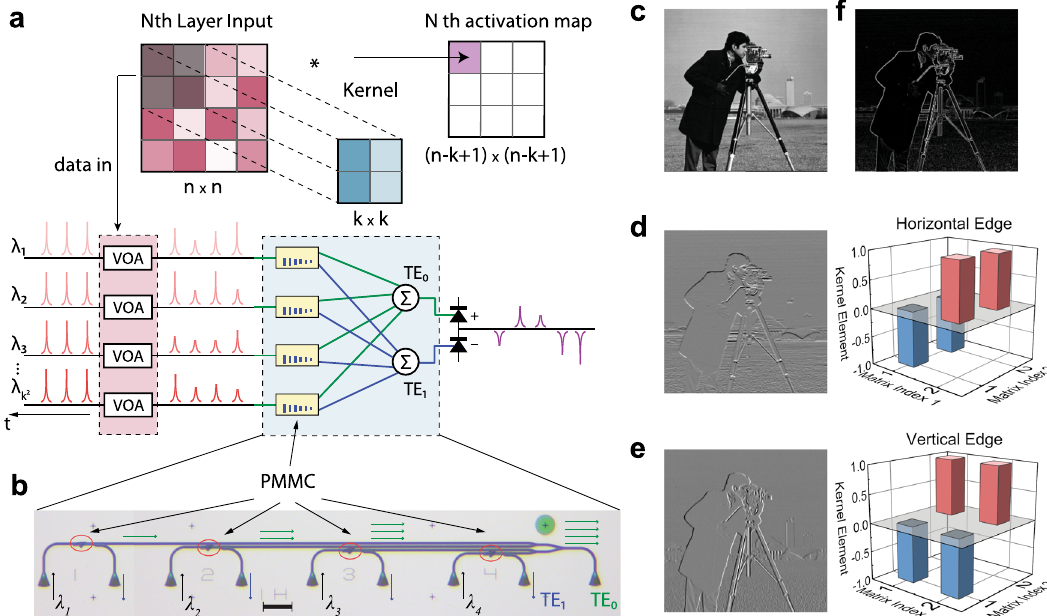
Fig. 3 Using a PMMC array as a photonic computing core for convolutional image processing. a Schematic of optical convolution for image processing. An array of k 2 PMMC is programmed to store the kernel matrix. A patch of pixels of an image is encoded as optical pulses and input into k 2 optical channels to perform MAC operation with the kernel. The output in TE 0 and TE 1 are summed incoherently and measured with photodetectors. The activation map is represented by the mode contrast and could be both positive and negative. b Optical microscope image of the photonic core consisting of four PMMCs with four input channels. The TE 0 mode outputs are summed on-chip with Y-junctions whereas TE 1 mode outputs are summed off-chip. Optical control pulses are input using the same set of grating couplers used for the TE 1 mode detection. c The greyscale image of “ cameraman ” (with permission from its copyright owner Massachusetts Institute of Technology) is used as the input image. d , e Left: the raw image generated by convolution with the kernel matrix for detection of horizontal ( d ) and vertical ( e ) edges. Right: the corresponding kernel matrix for edge detection. f Combined image of horizontal and vertical edge detection, highlighting all the sharp edges in the original